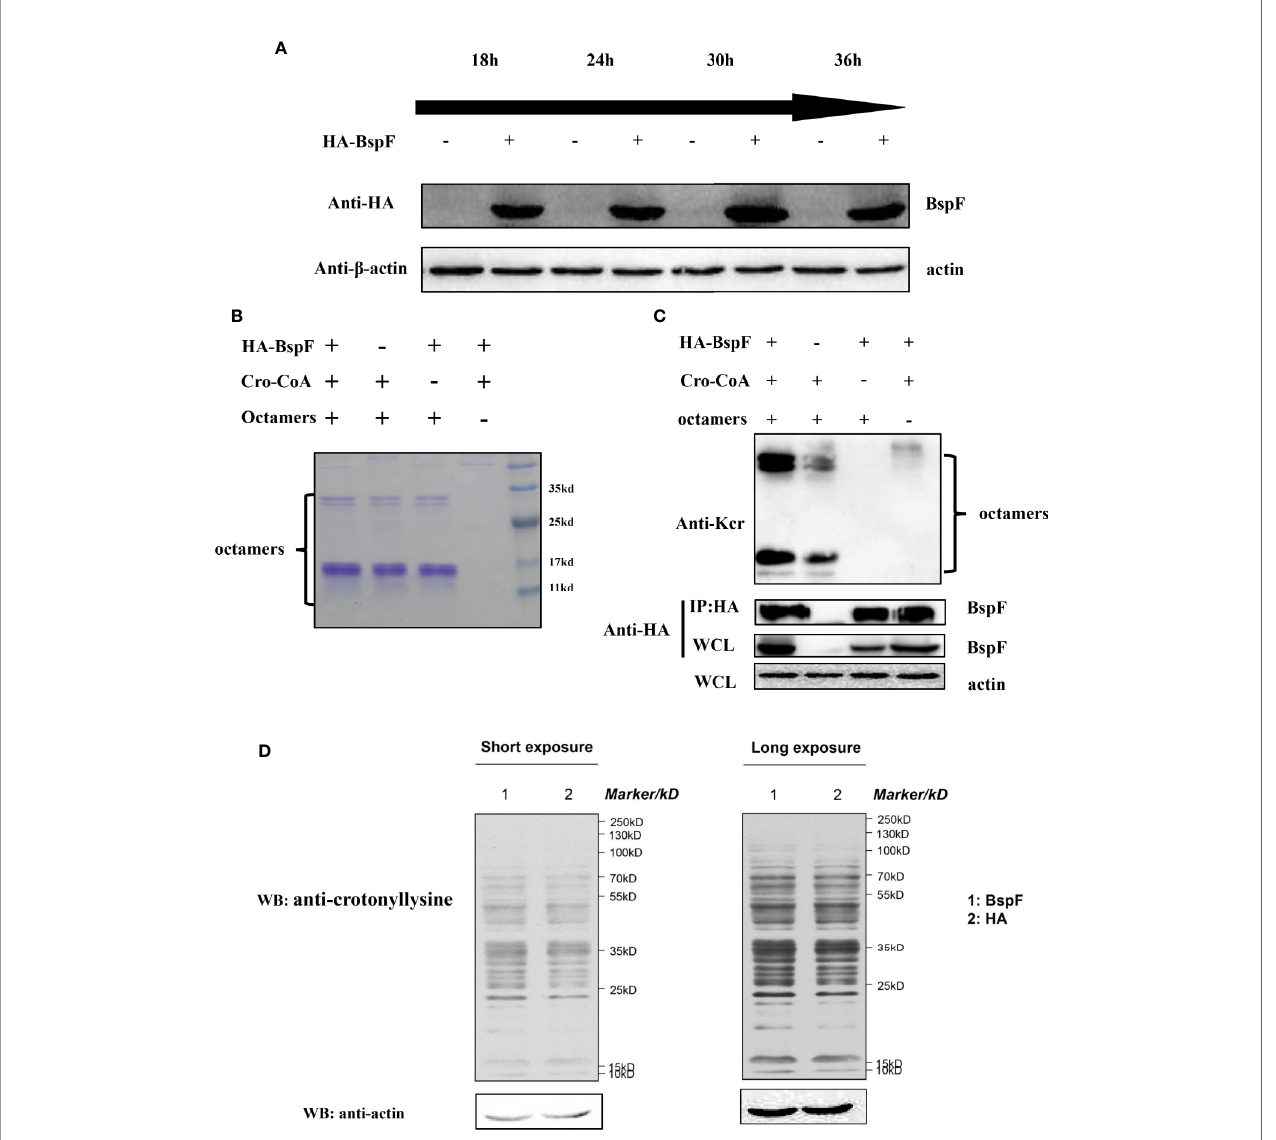
FIGURE 2 | The de-crotonylase activity of BspF overexpressed in vivo is affected. (A) Overexpression of BspF in HEK-293T cells. At 30 h after transfection, the expression of BspF was highest. (B, C) In complex cellular environments, the de-crotonylase activity of BspF is disturbed due to its interacting proteins. (B) The SDS-PAGE Coomassie staining of the enzymatic activity experiment reaction system showed that the content of the same components in each system was consistent. (C) The protein content of the immunoprecipitation is low, and the expression of BspF cannot be clearly seen in Coomassie staining, so we use western- blot to ensure the expression and uniformity of BspF. Because of interacting partners of BspF, the de-crotonylase activity of BspF is disturbed. (D) Western-blot of whole HEK-293T cells lysis with anti-crotonyllysine